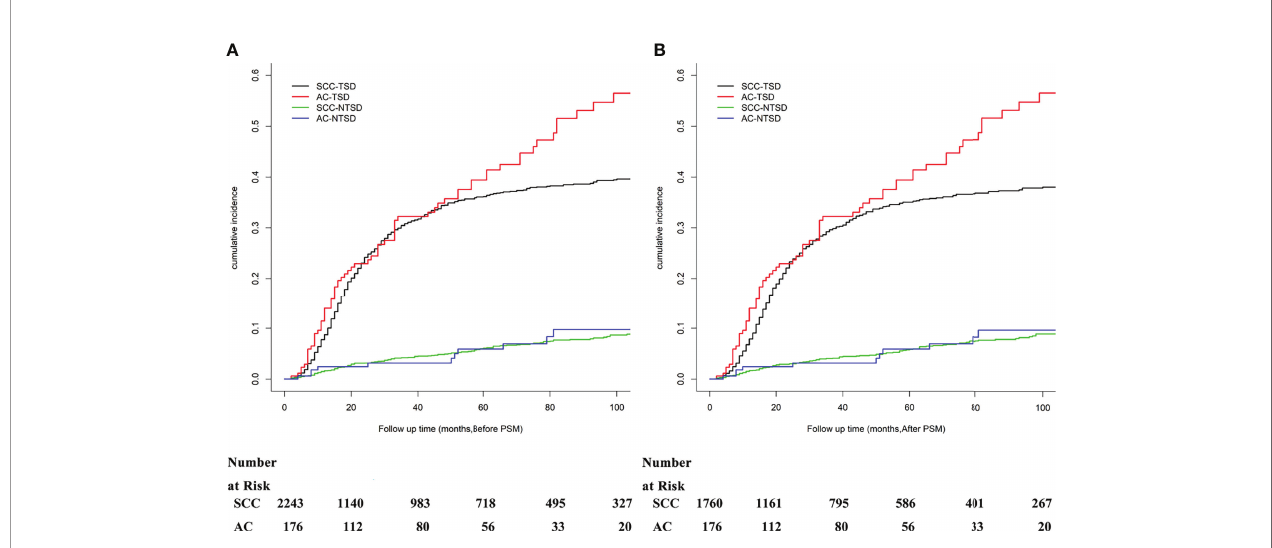
FIGURE 2 | The cumulative risk curves according to TSD and NTSD before (A) and after (B) PSM.